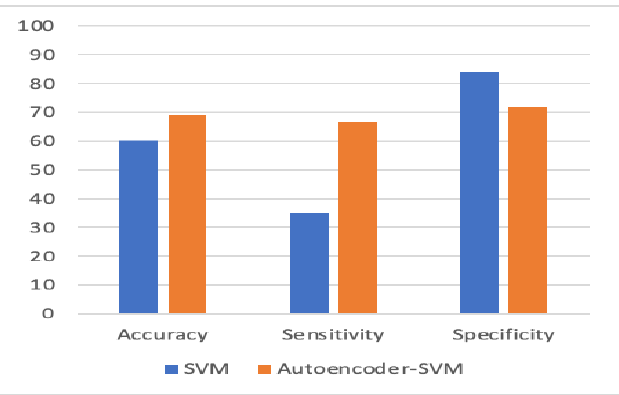
Figure 11. Autoencoder-SVM vs. SVM.